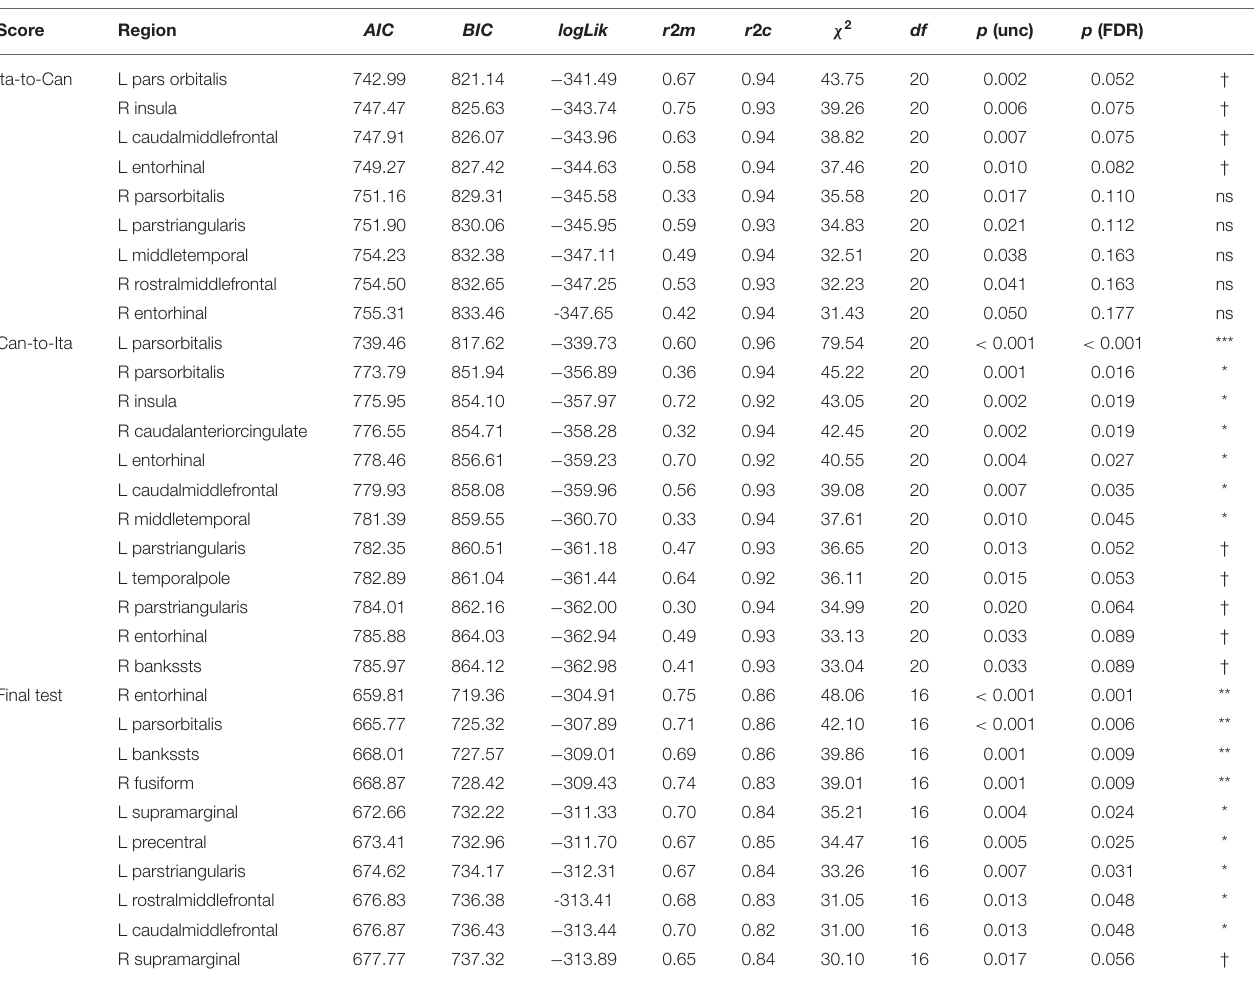
TABLE 4 | Cortical ROIs showing significant associations with the Italian learning performance. Score